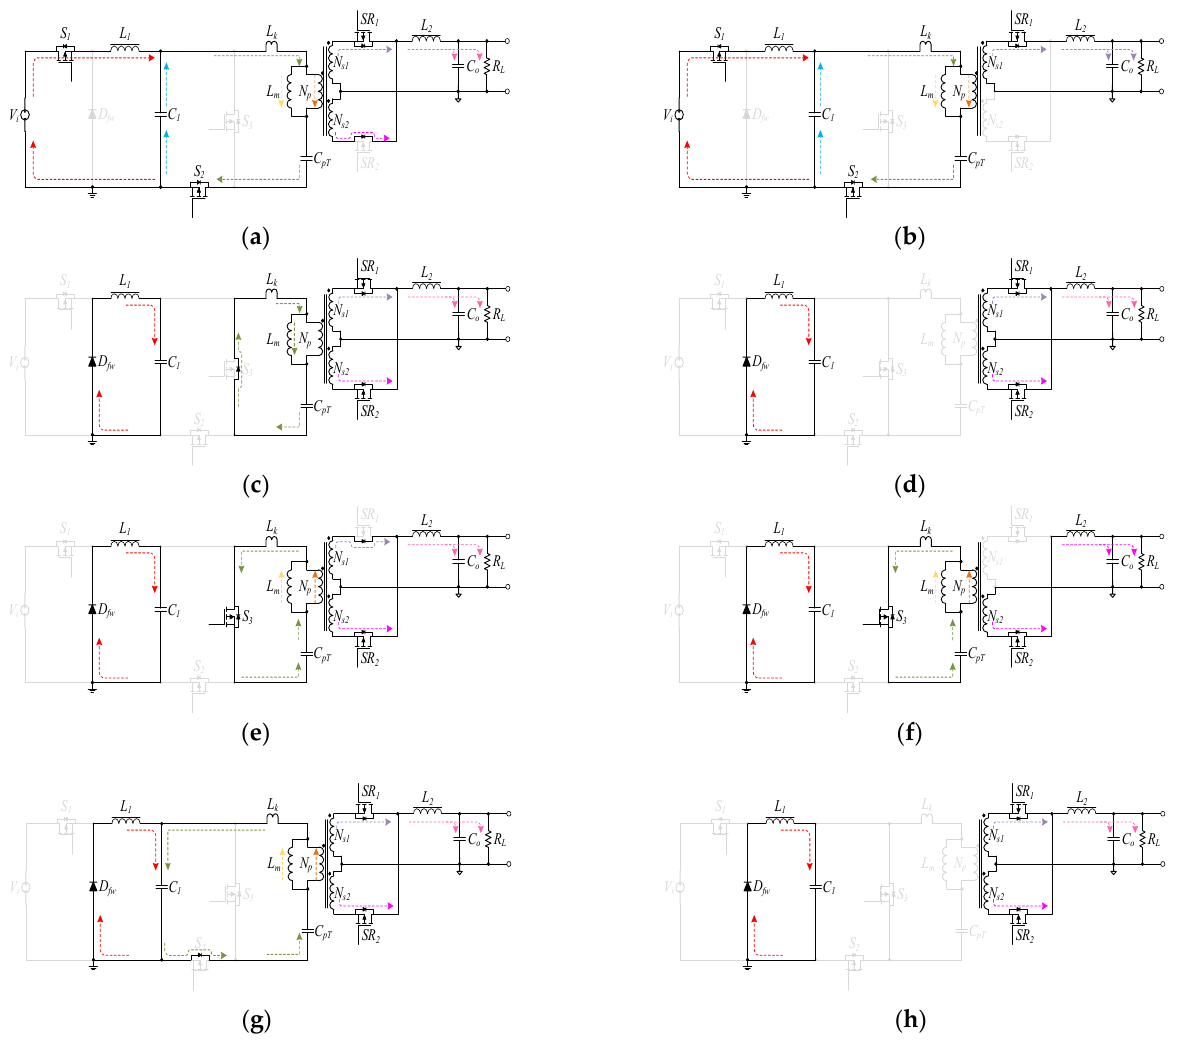
Figure 5. The proposed IBAHB operating modes: ( a ) Mode 1 [ t 0 , t 1 ], (b ) Mode 2 [ t 1 , t 2 ], ( c ) Mode 3 [ t 2 , t 3 ], ( d ) Mode 4 [ t 3 , t 4 ], ( e ) Mode 5 [ t 4 , t 5 ], ( f ) Mode 6 [ t 5 , t 6 ], ( g ) Mode 7 [ t 6 , t 7 ] and ( h ) Mode 8 [ t 7 , t 8 ].